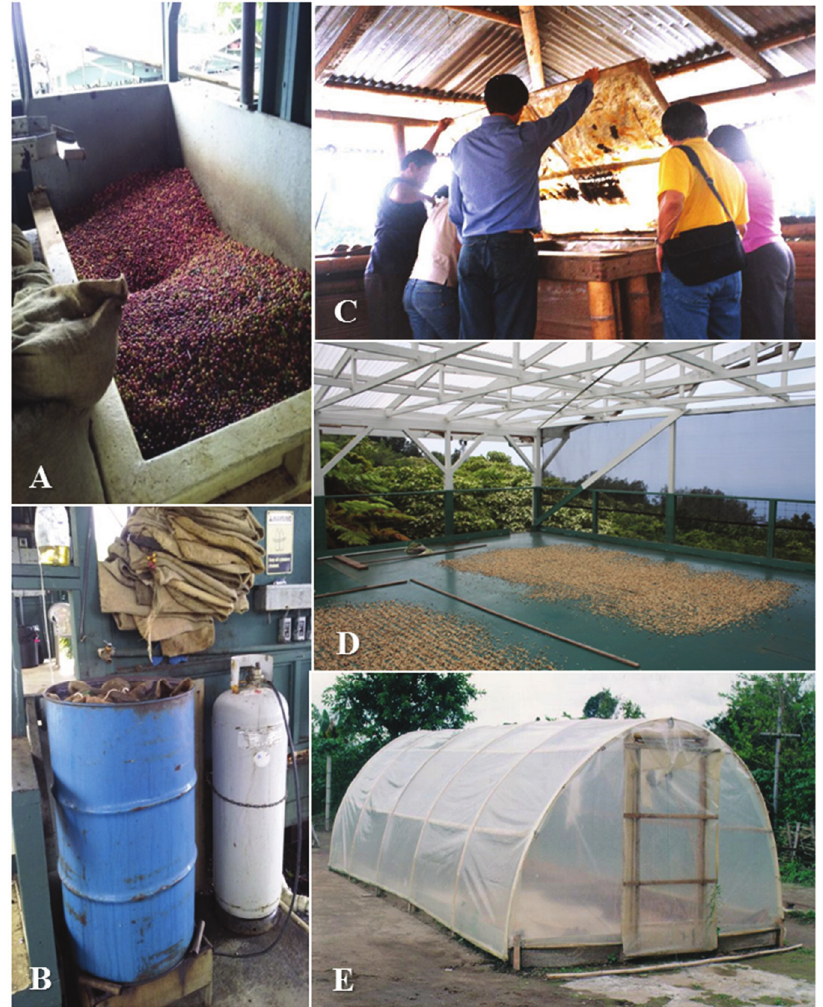
Figure 5. Silos used to process harvested coffee without cover allows escape of CBB ( A ), container with hot water to control CBB in harvest bags ( B ); silo cover with transparent plastic smeared with grease to capture CBB in Colombia ( C ); drying parchment coffee in open areas allow escape of CBB ( D ); and enclosure for dry parchment coffee used to prevent CBB escape in Colombia, ( E ). Coffee plantations in Kona, Hawaii and in Quimbaya, Colombia. Photos taken by Luis F. Aristizábal.